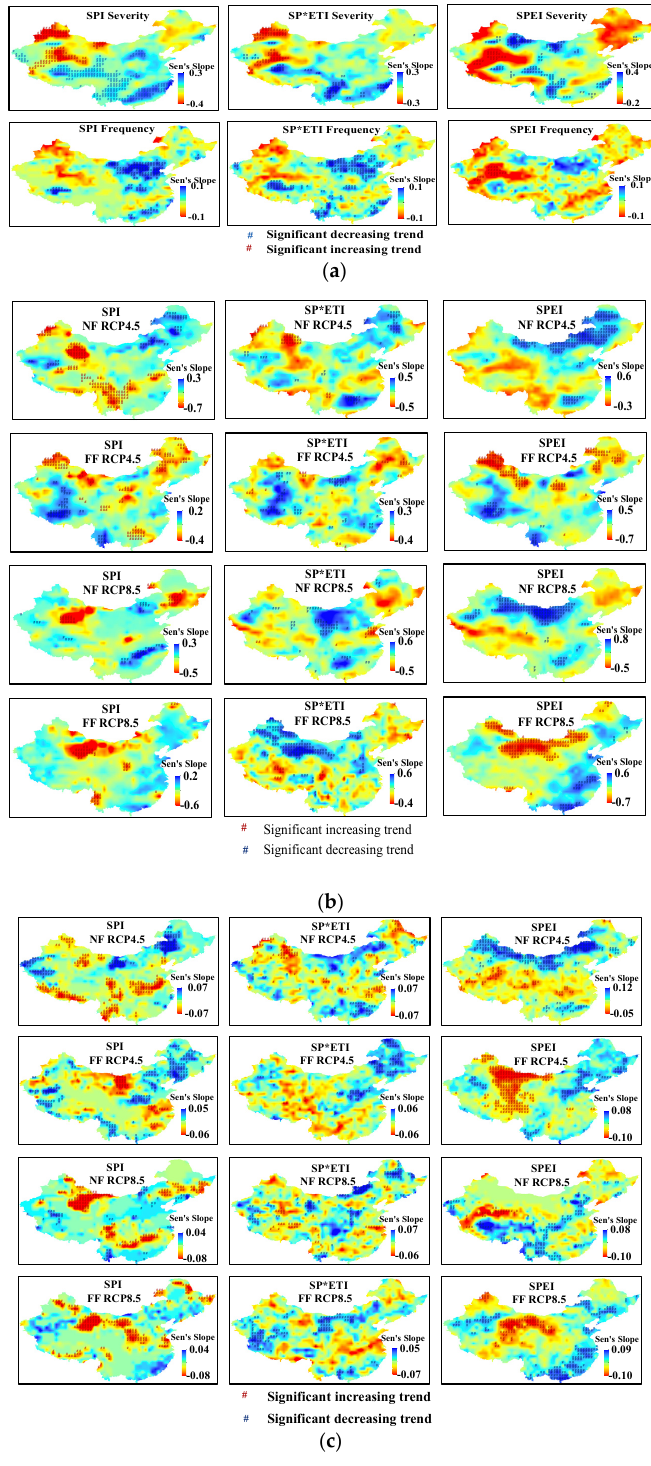
Figure 8. ( a ). Mann–Kendall and Sen’s slope test results of the drought severity and frequency of historical droughts for the SPI, SP*ETI, and SPEI drought indicators. Blue triangles represent a significant decreasing trend and red triangles represent a significant increasing trend. ( b ). Mann–Kendall and Sen’s slope test results of the drought severity of NF and FF for the SPI, SP*ETI, and SPEI drought indicators. Blue triangles represent a significant decreasing trend and red triangles represent a significant increasing trend. ( c ). Mann–Kendall and Sen’s slope test results of the drought frequency of NF and FF for the SPI, SP*ETI, and SPEI drought indicators. Blue triangles represent a significant decreasing trend and red triangles represent a significant increasing